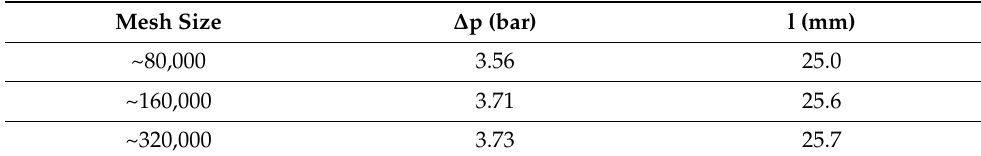
Figure 3. The geometry of the microchannel computational domain and the mesh detail in the wedge apex area. Table 1. Mesh independence